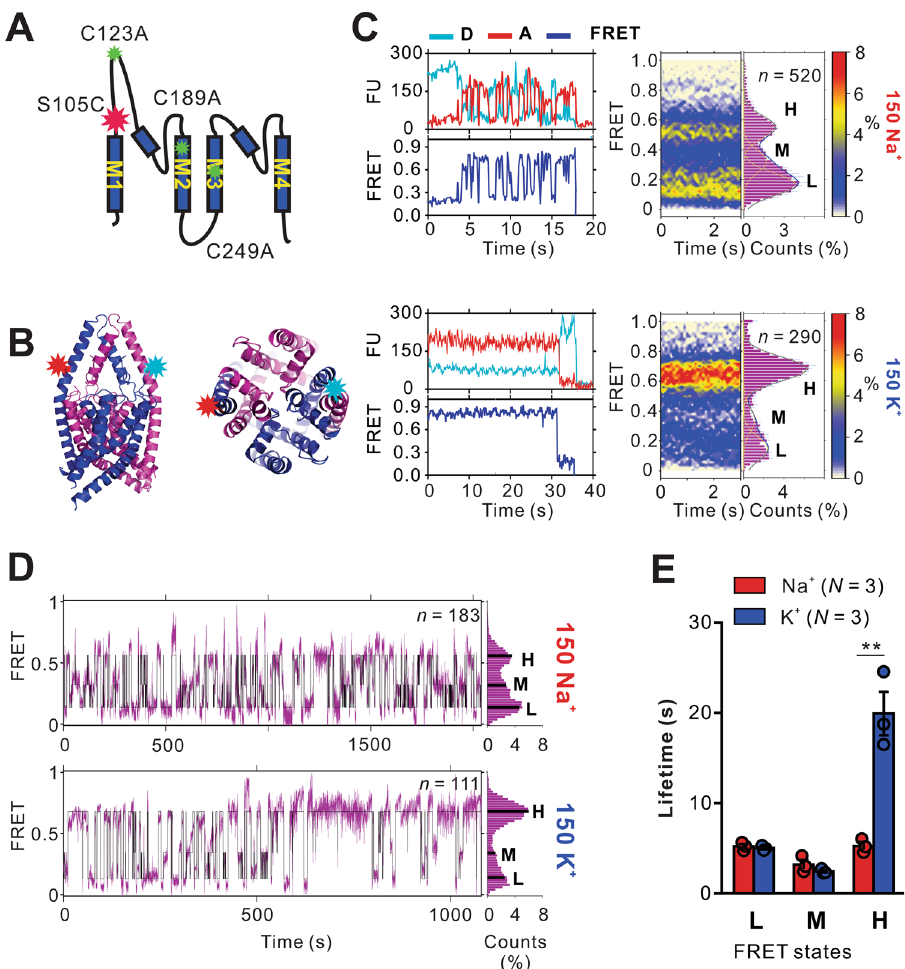
Fig. 5 | Ion-dependent selectivity fi lter in TREK2. A Cysteine to Alanine muta- tions to obtain cysteine-less TREK2 mutant. B Strategy for introducing two free cysteines within the dimeric TREK2 cysteine-less channel. The cysteine is intro- ducedatpositionS105atthetoppartofthe fi rstsubunit(S1)TM1domain.Domain organizations of the resulting proteins labeled with Alexa Fluor 555/647 c2 mal- eimidepair(PBD4BW5) .C RepresentativesmFRETtracesforTREK2S105C,aswell as FRET contour plots and histograms ( n =520 and 290 TREK2 traces, in the pre- senceof150mMNaClorKCl,respectively). D Concatenated(mauve)andidealized